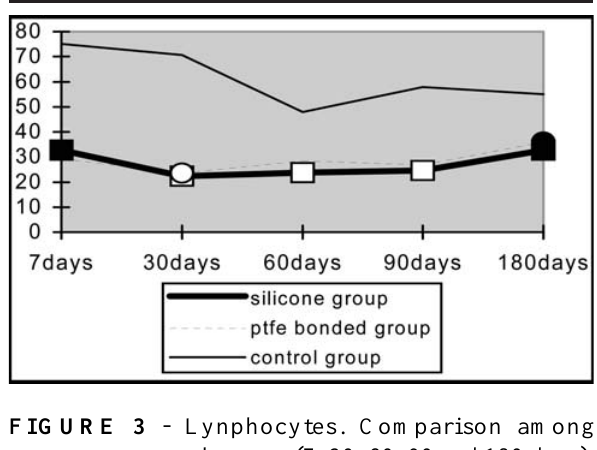
FIGURE 3 - Lynphocytes. Comparison among subgroups (7, 30, 60, 90 and 180 days), of each group separately. The significant value is indicated with a dark line and the comparison in a light one